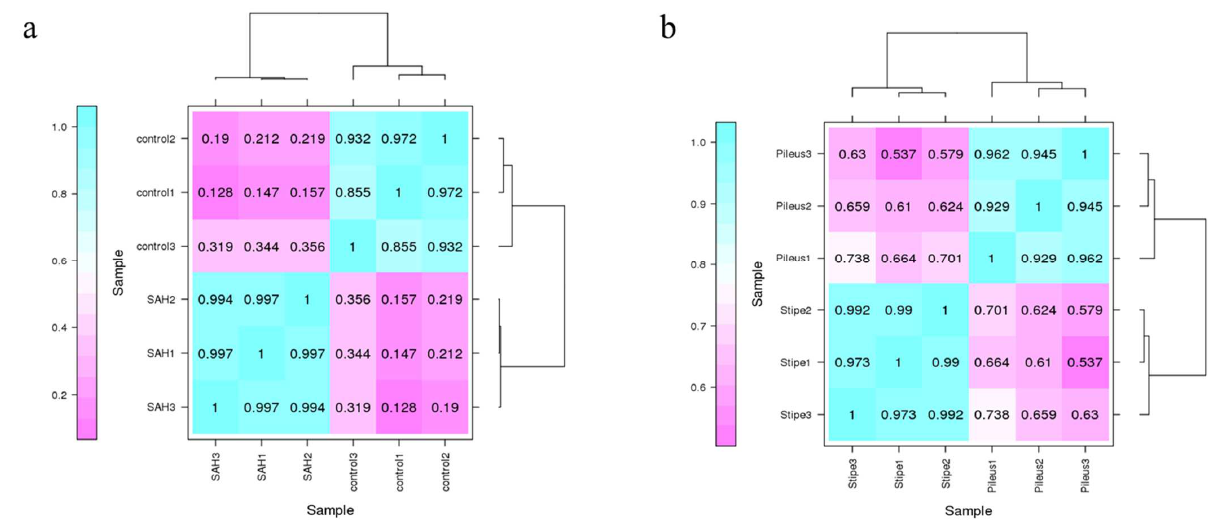
Figure 2. The Pearson correlation coefficients for relationships of transcriptomes data for different treatments ( a ) and different parts of the fruiting body ( b ).